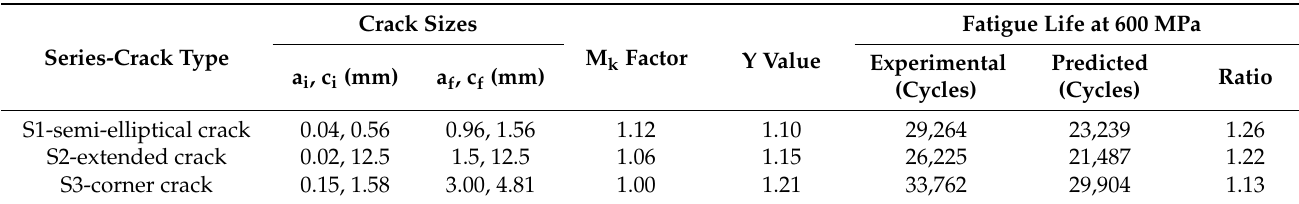
Table 6. Data and parameters for the predictions of the fatigue